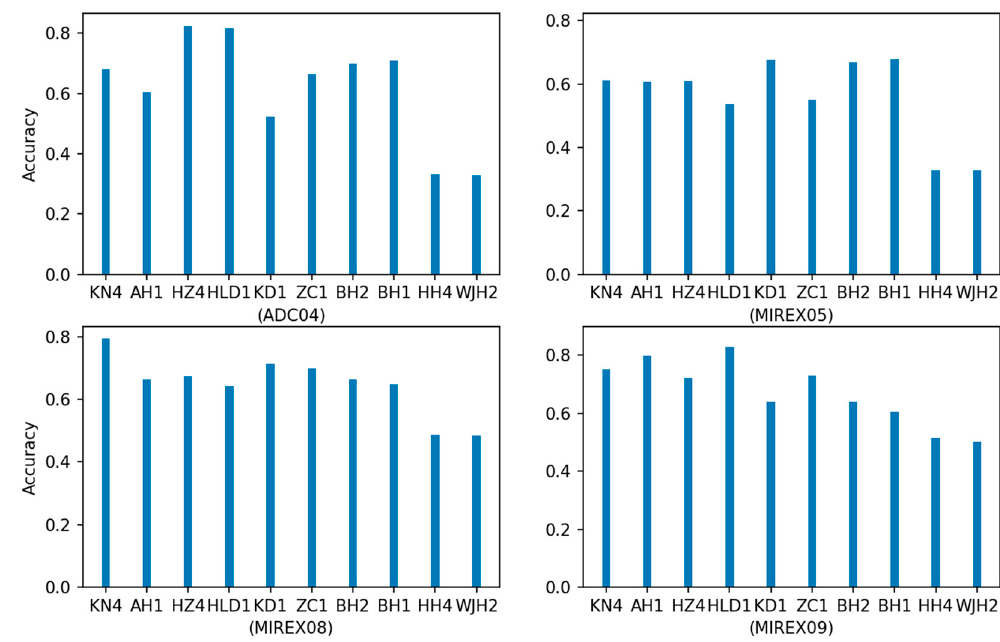
Figure 9. Overall accuracy (OA) results in each collection for an audio melody extraction task.